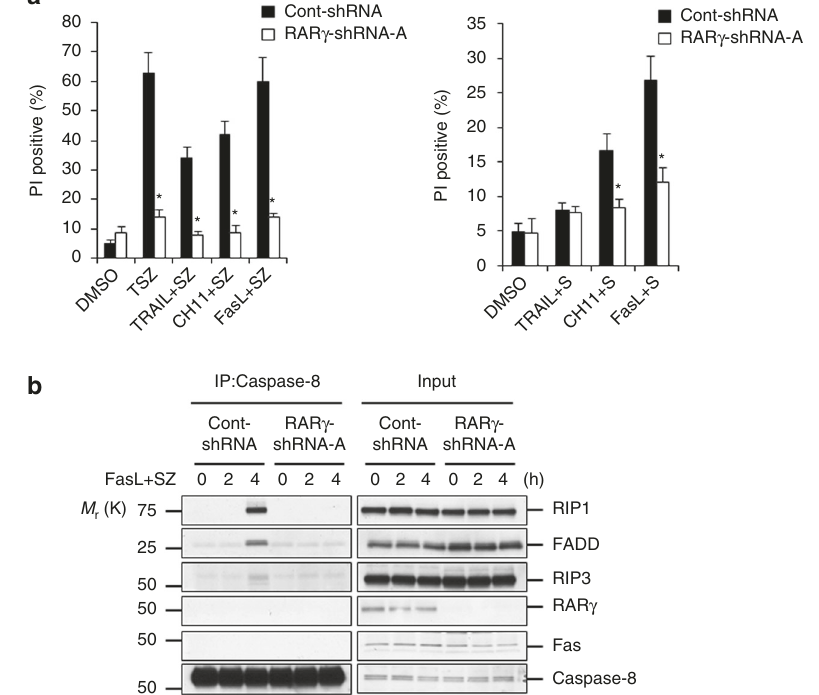
Fig. 6 RAR γ is involved in death receptor and genotoxic stresses-induced cell death. a Cell death analysis of HT-29 cont-shRNA and RAR γ -shRNA-A treated with DMSO, TSZ, TRAIL + SZ, CH11 + SZ or FasL + SZ for 24 h ( left panel ), or treated with DMSO, TRAIL + S, CH11 + S or FasL + S for 24 h ( right panel ). Cell death was determined by PI staining using fl ow cytometry. (* P < 0.05 versus cont-shRNA; ANOVA). The bars represent the mean ± s.e.m. of three experiments. b HT-29 cont-shRNA, and RAR γ -shRNA-A treated with FasL + SZ for the indicated times. Cell lysates were immunoprecipitated with anti-Caspase-8 antibody and analyzed with the indicated antibodies. Blots are representative of one of the three